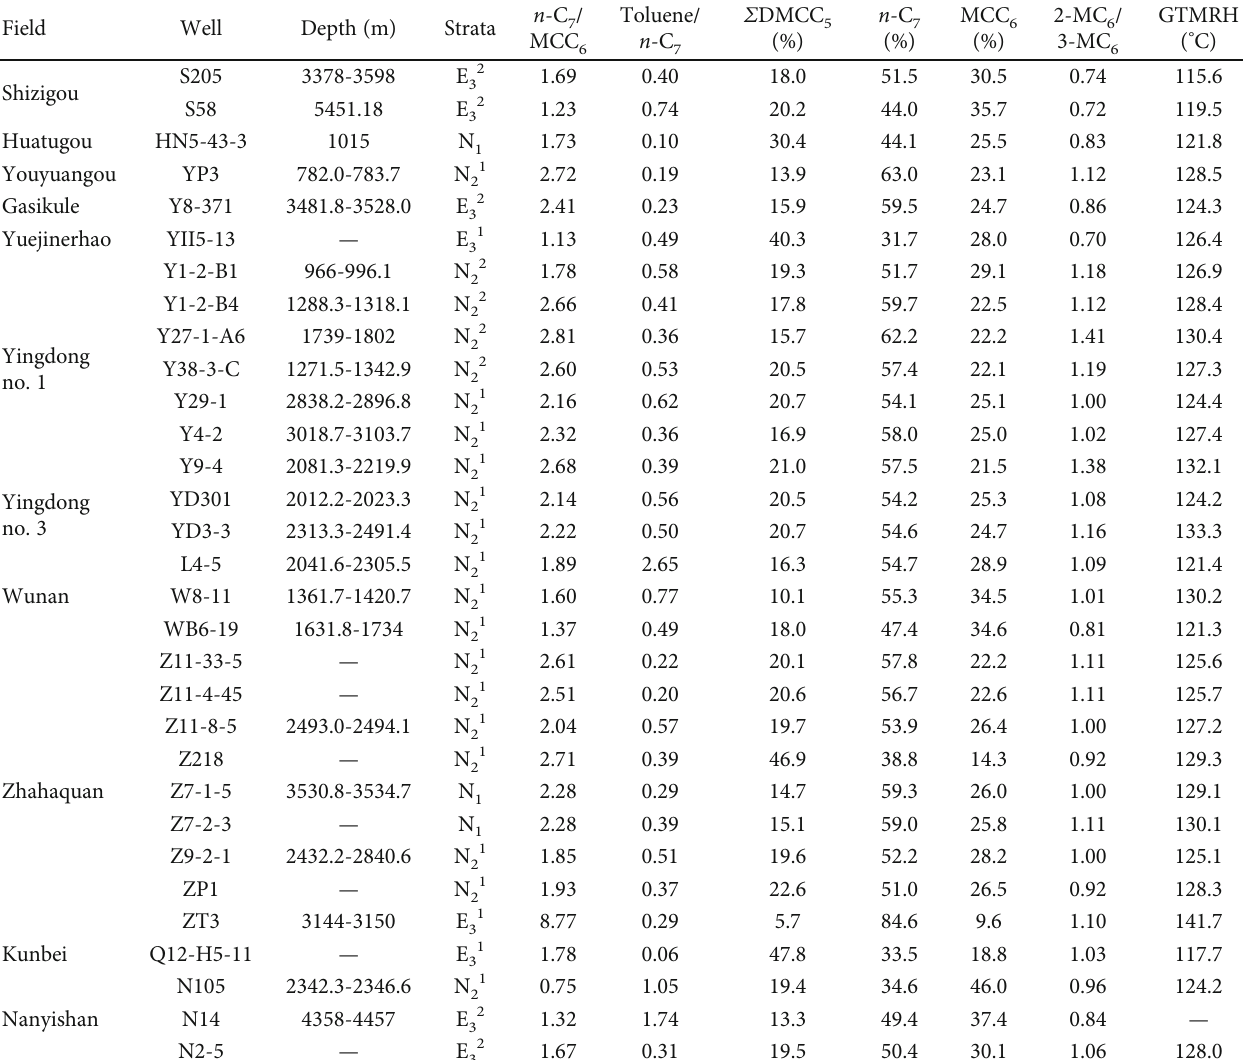
Table 1: Representative light hydrocarbon geochemical parameters in natural gas from the western Qaidam Basin. Field